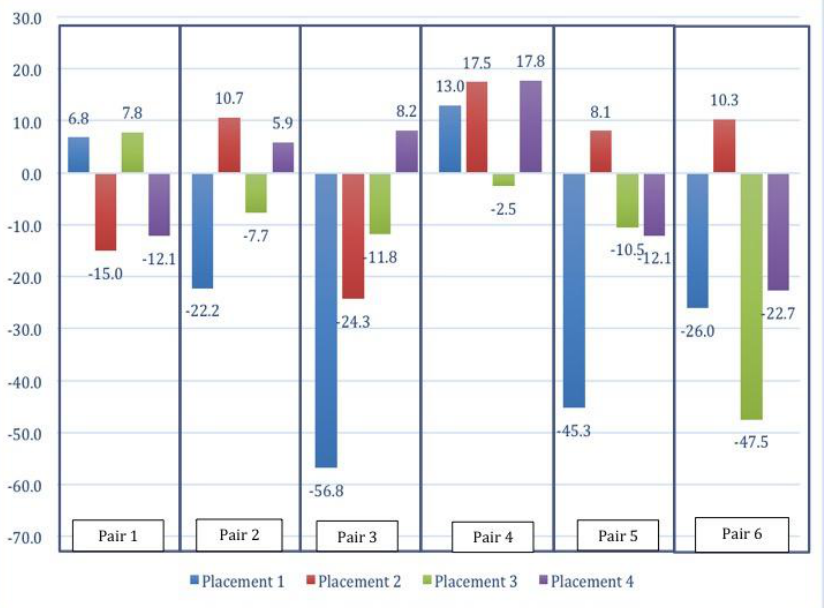
Figure 2. Graphical depiction of the percentage difference between total activity counts for each placement period for each device pair. Percentage difference was calculated using the formula: 1-[Total Activity Device 1/Total Activity Device 2]*100. Therefore, negative values indicate a greater activity count of Device 1. For example, Pair 1 Device 1 had a 15% greater total activity count during P2 but a 7.8% lower total activity count during P3. P1 is depicted in blue, P2 in red, P3 in green, and P4 in purple.